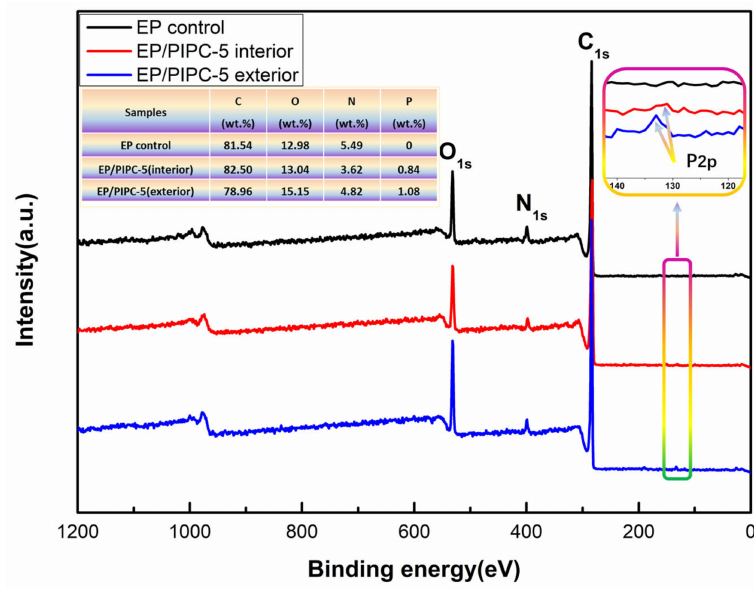
Figure 8. XPS survey spectra of the internal and external residual char of the EP control and EP / PIPC-5